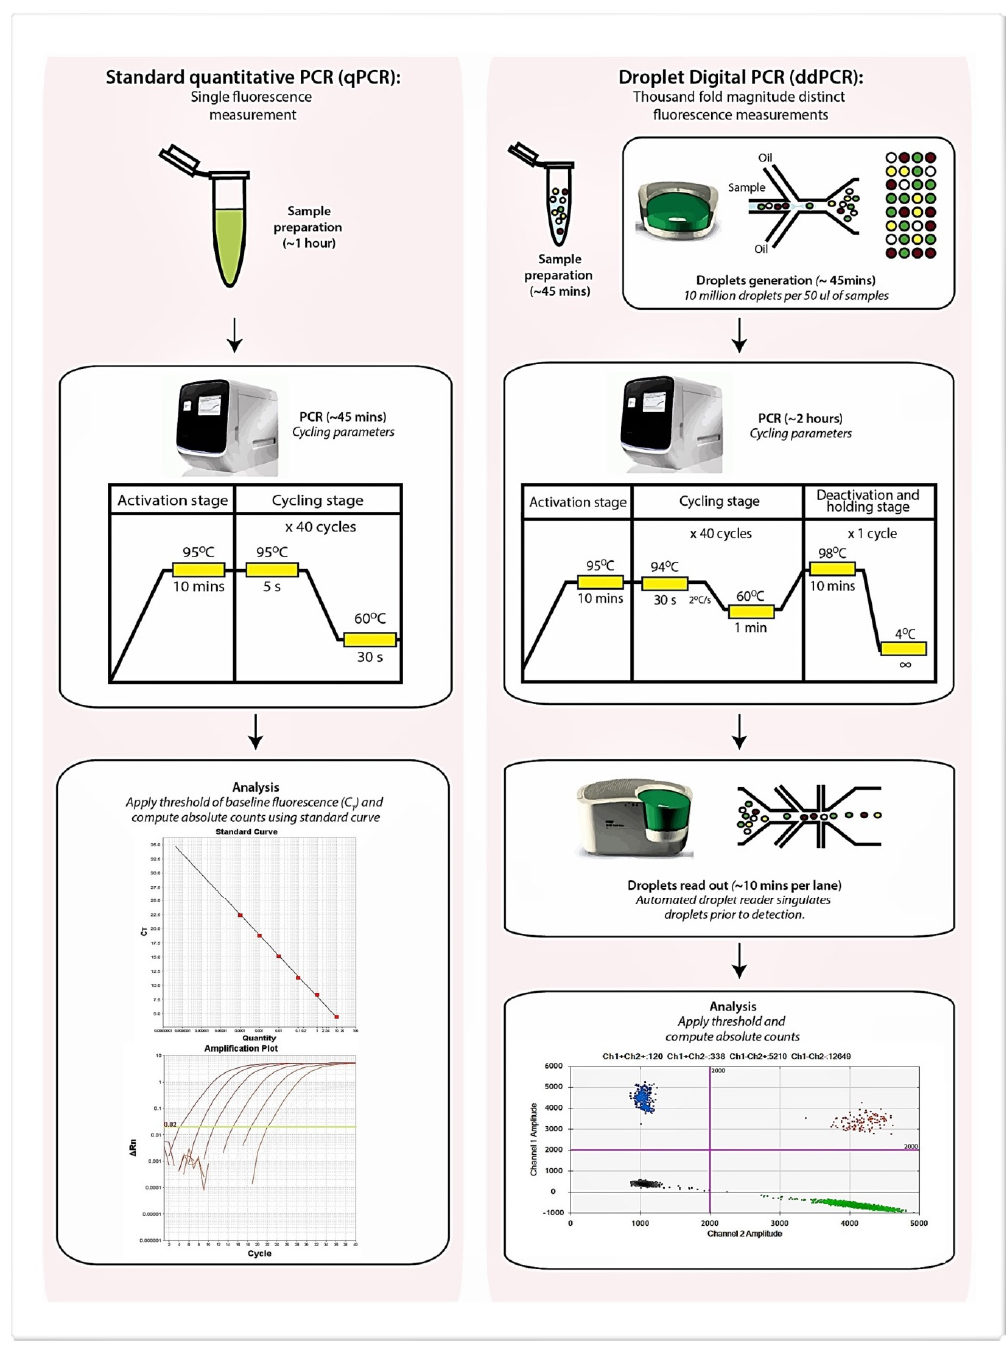
Figure 1. Schematic diagram illustrating protocol related differences between qPCR and droplet digital PCR (ddPCR) including the estimated time required at each step. Sample preparation for both qPCR and ddPCR while comparable is slightly longer for qPCR due to a requirement for standard curve preparation to allow quantification and inclusion of an internal positive control to exclude PCR inhibition.